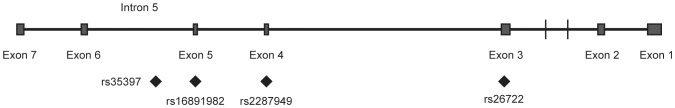
SNPs found in the resequencing of SLC45A2.We show the location of the 3 SNPs found in the coding region of the gene: rs16891982, rs2287949 and rs26722, plus the most frequent SNP in intron 5: rs35397.